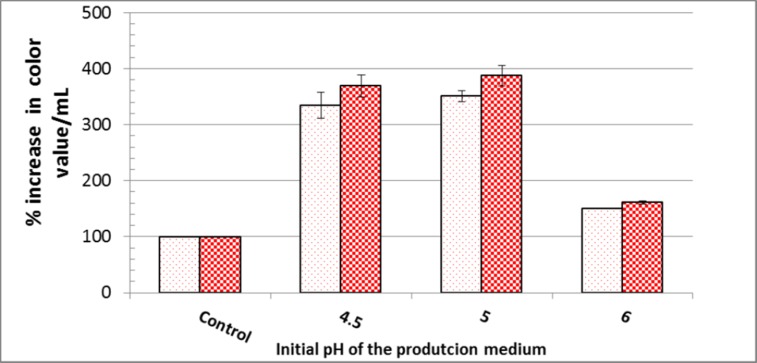
Effect of initial pH of the production medium on orange and red monascus pigments production.Dotted bars: orange moanscus pigments. Checkboard bars: red monascus pigments.